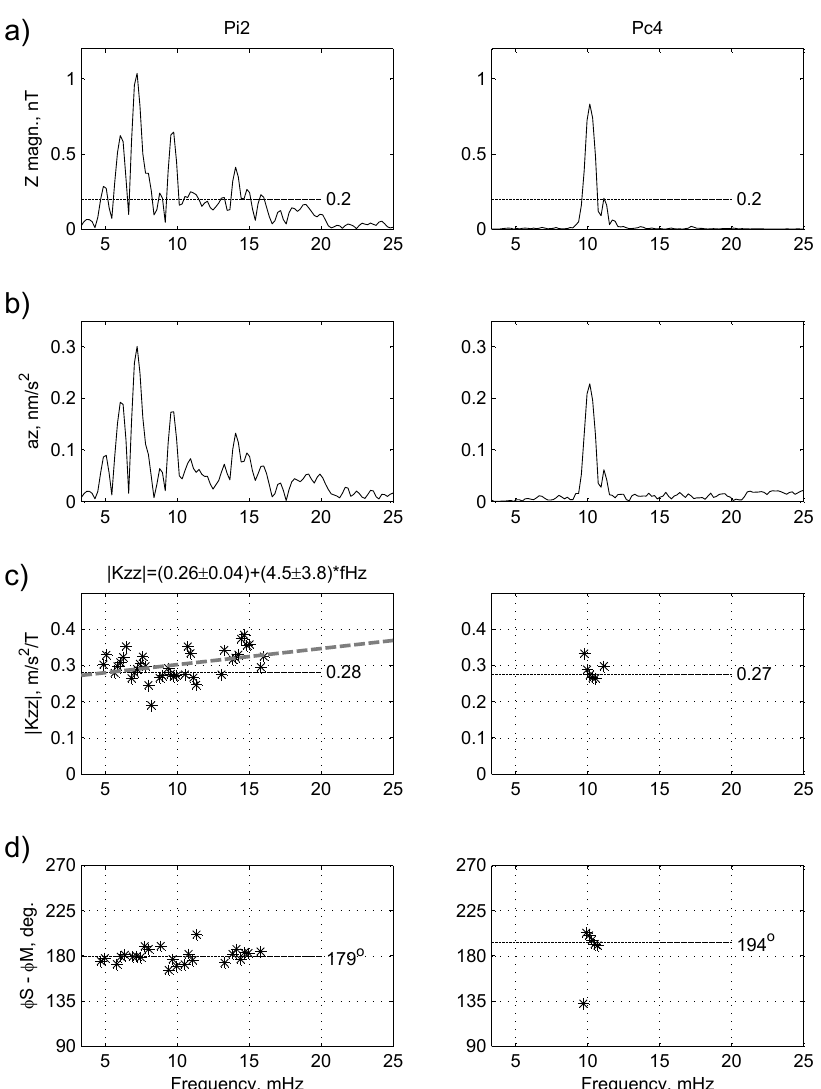
Fig. 13. Amplitude spectra of the magnetic (top panels) and seismic (the second row from the top panels) signals in Z -component for the cases of Pi2 (on the left) and Pc4 (on the right) geomagnetic pulsations observed in Kilpisjarvi. The third row from the top panels (c) shows the amplitude ratio of seismic-to-magnetic signals, which corresponds to the Kzz coefficients calculated for different frequencies. The ratios are shown only for the spectral components at which amplitudes of magnetic signal exceed a noise level of 0.2nT. The bottom panels show the phase shift (near 180 ◦ ) between seismic and magnetic